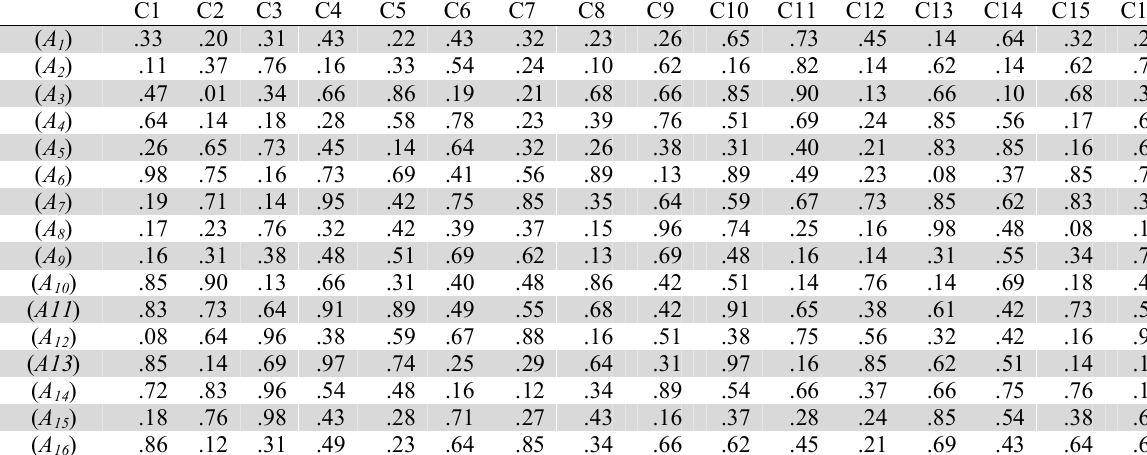
Relative weight of each firm based on different criteria